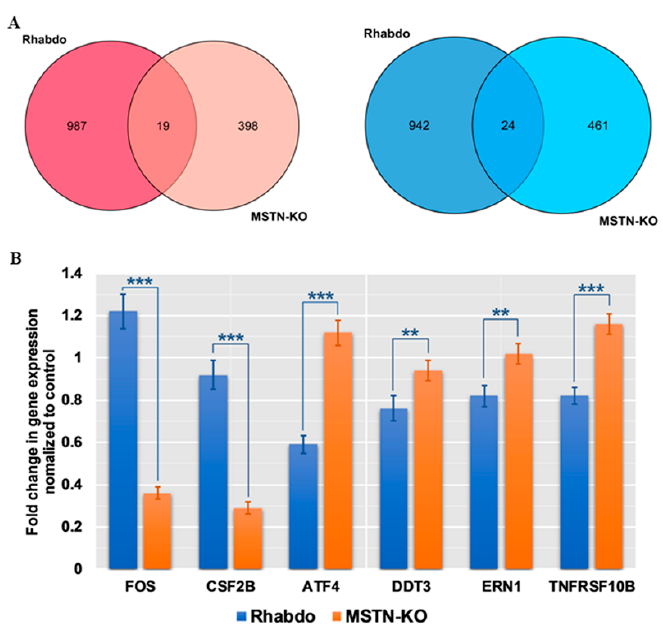
Figure 5. Expression analysis of DEGs between the MSTN-KO and rhabdo groups. ( A ) Overlapping DEGs between the MSTN-KO and rhabdo groups. ( B ) Apoptosis-related gene expression differences between the KO and rhabdo groups. All data are shown as the mean ± SEM. Two-tailed Mann–Whitney U tests were used for pairwise comparisons between groups. ** p < 0.01, *** p < 0.001.